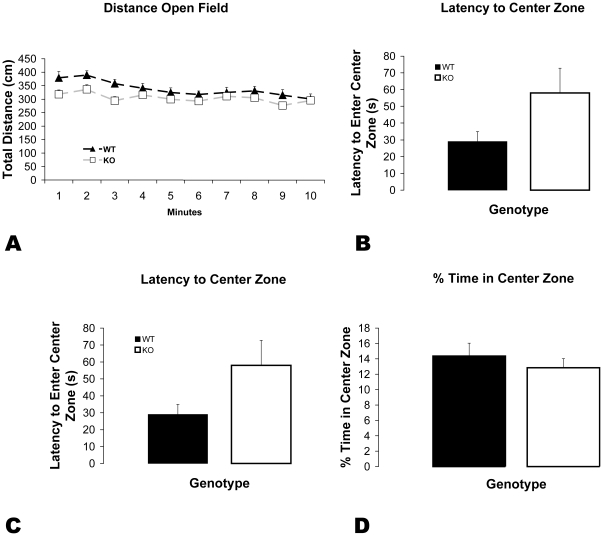
Open Field.A) 5-HTT KO mice show significantly decreased distance traveled throughout the arena in a novel open field. This is seen during the first 3 minutes of the test. B) KO mice show a non significant increase in latency to enter center zone C) There was no significant genotypic differences in number of entries into the center zone D) There was no significant genotypic difference in time spent in the center zone. Error bars represent standard error of the mean.